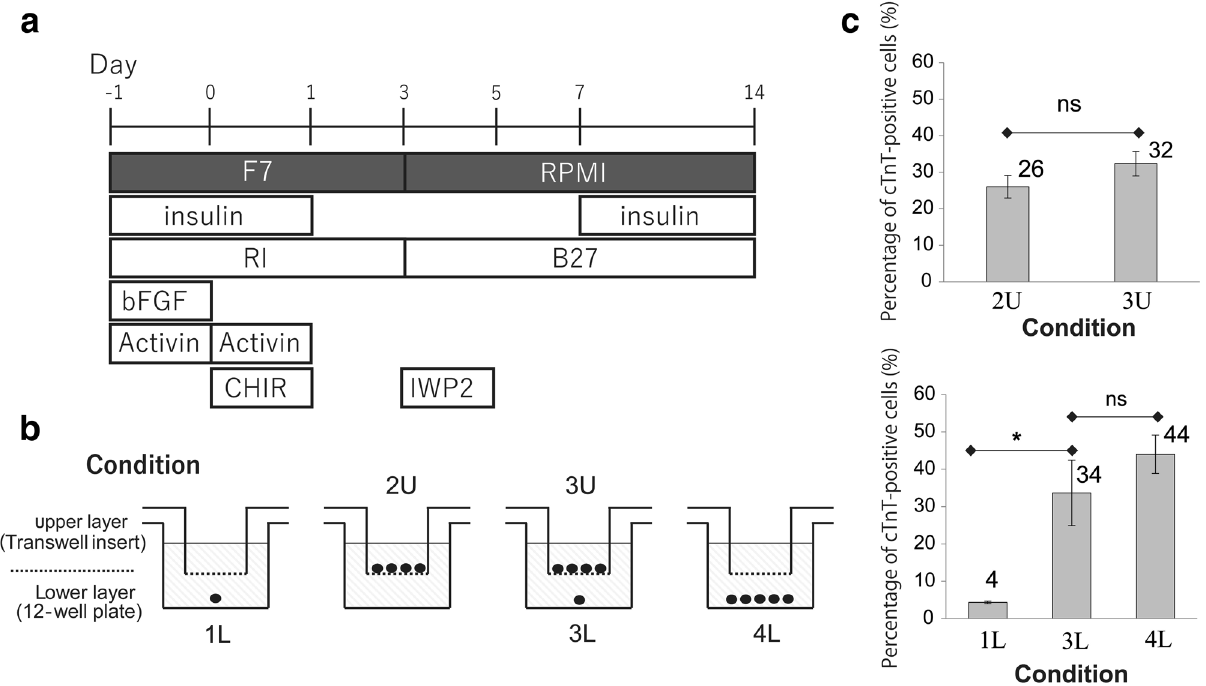
Figure 1. Co-culture of cells plated at an initial high cell density enhanced the cardiomyocyte differentiation efficiency of cells plated at an initial low cell density. ( a ) Schematic of the previously established protocol of cardiomyocyte differentiation 14 . ( b ) Schematic of co-culture experiments. The cells were plated as follows. Cells were plated at a low cell density of 5 × 10 3 cells/cm 2 and high cell density of 2 × 10 5 cells/cm 2 . Condition 1: Only low cell density cells in the lower layer (L indicates lower). Condition 2: Only high-density cells in the upper layer (U indicates upper). Conditions 1 and 2 were used as controls. Condition 3: Co-culture of high-density cells in the upper layer and low cell density cells in the lower layer to assess cell-secreted signals. Condition 4: The same total number of cells at an initial low and high density, as specified in condition 3, was plated on the same surface to assess both cell-secreted signals and cell–cell contact signals. ( c ) The percentage of cTnT- positive cells measured by flow cytometry on day 14. Mean ± standard error (SE), * P < 0.05, t-tests with Holm’s correction, ns: non-significance, n =